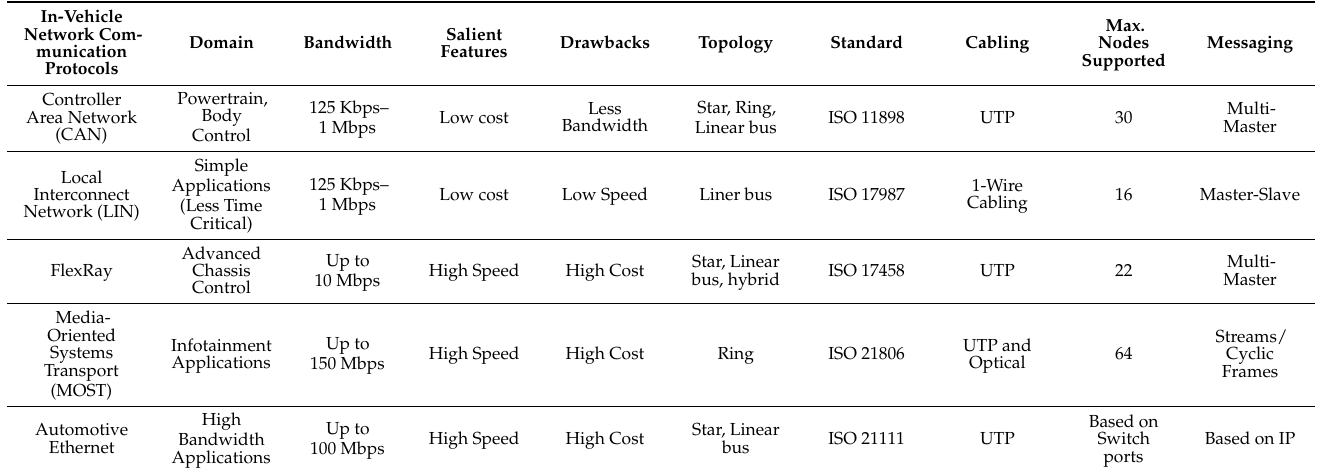
Table 1. Classification of in-vehicle network communication